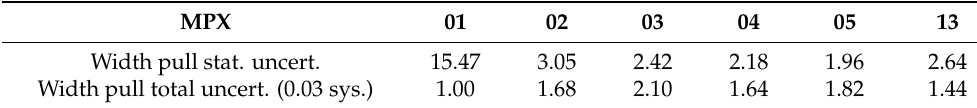
Table 8. Widths of the Gaussian fits to the pull distributions for MPX01-05 and MPX13. The widths are given for uncertainties resulting from the number of hits scaled by a factor MPX device, given in Table 5. The widths are also given for statistical and systematic uncertainties added in quadrature. The systematic uncertainties result from luminosity fluctuations not described by the fit function. Table 9 indicates the sizes of the uncertainty applied. LHC fill 3236. Taken from Ref. [11]. MPX 01 02 03 04 05 13 Width pull stat. uncert. 15.47 3.05 Width pull total uncert. (0.03 sys.)